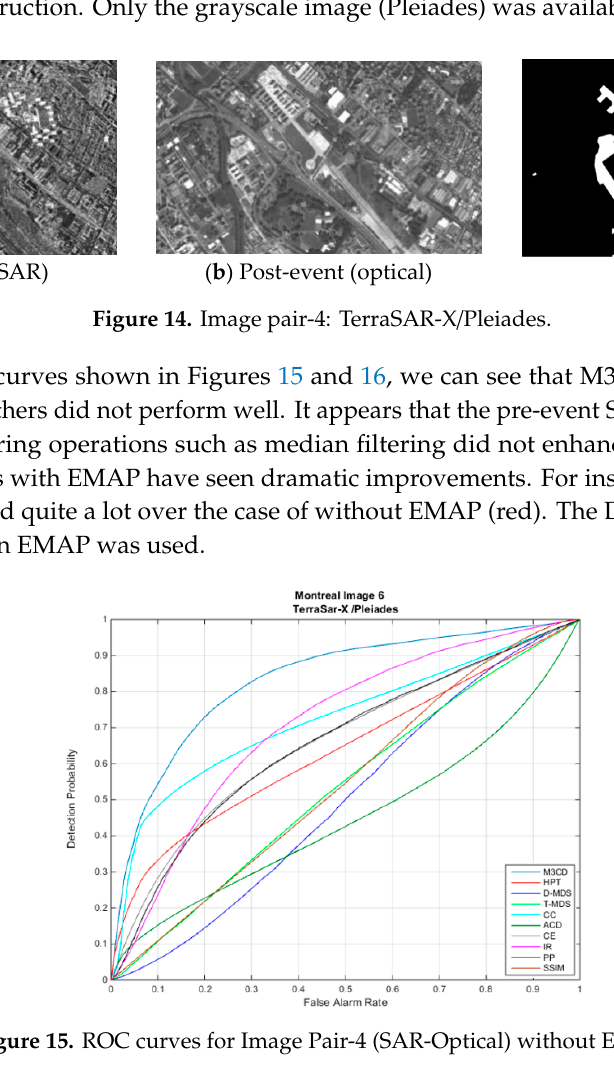
Figure 15. ROC curves for Image Pair-4 (SAR-Optical) without EMAP.